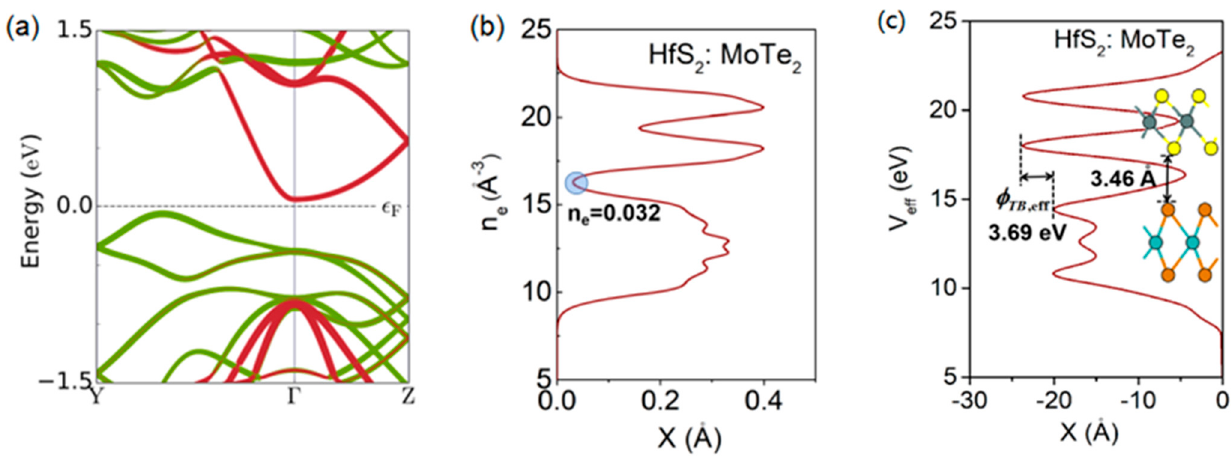
Figure 2. ( a ) Band structures of the HfS 2 /MoTe 2 heterojunction. The electronic states contributed by HfS 2 and MoTe 2 are marked by the red and green curves, respectively. The Fermi level is referenced to zero. ( b ) Average electron density, n e . ( c ) Effective potential, V eff .